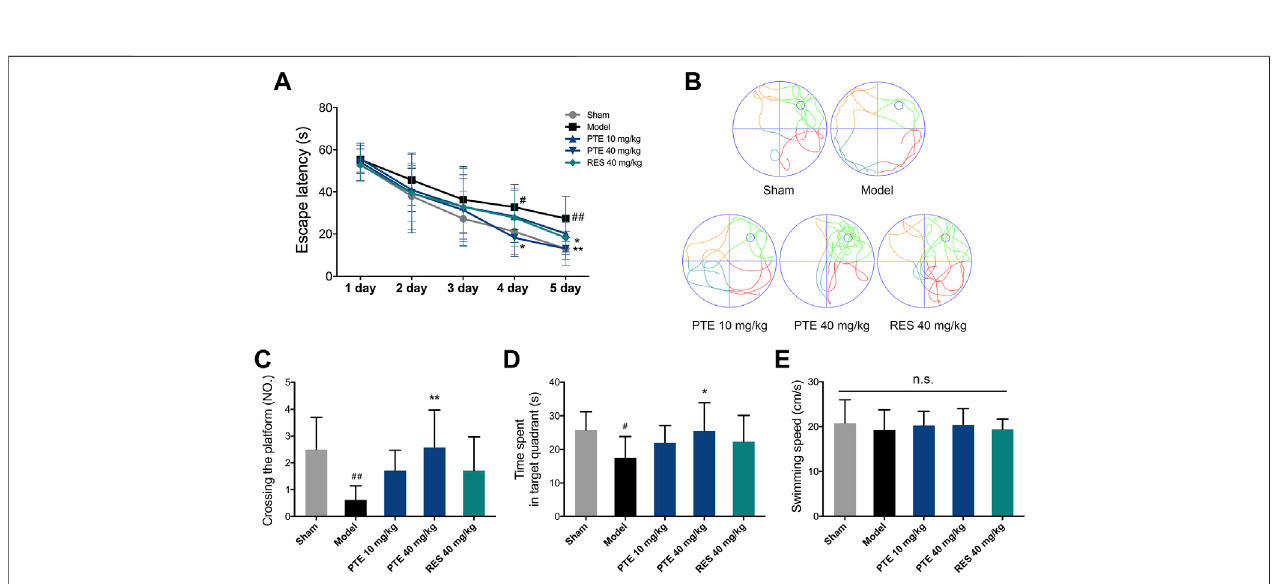
FIGURE 4 | Effects of PTE and RES on Morris water maze test in AD mice. (A) Escape latency in the Morris water maze test during the training period. (B) Typical swimmingtracksofmiceintheprobetest. (C – E) Quanti fi cationofthenumberofcrossingtheplatform,exploringtimeinthetargetquadrant,andswimmingspeedduring the probe test. Data are shown as mean ± SD (n = 7 – 8). # p < 0.05, ## p < 0.01 vs sham; * p < 0.05, ** p < 0.01 vs model.